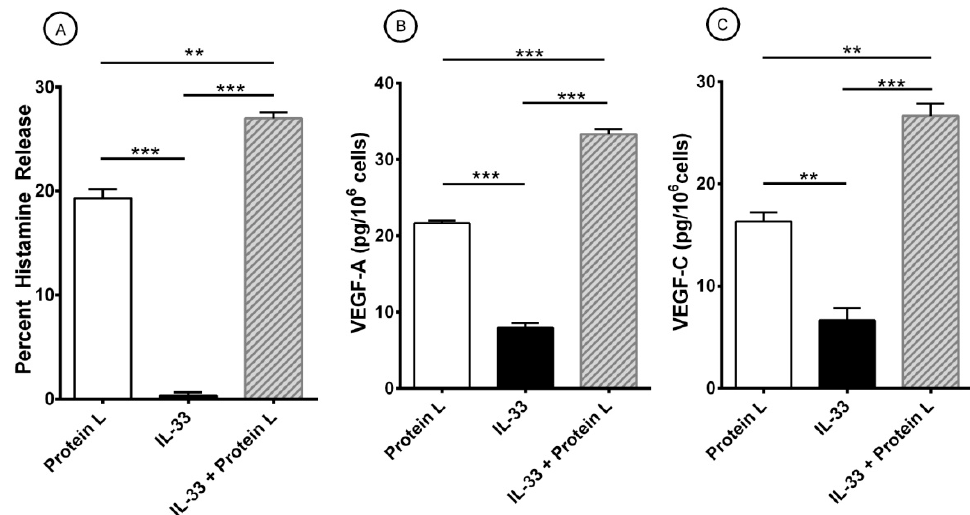
Figure 5. Effects of short-term priming by IL-33 and protein L-induced release of histamine ( A ), VEGF-A ( B ), and VEGF-C ( C ) from HLMCs. Mast cells were preincubated (30 min at 37 ◦ C) with IL-33 (30 ng/ml) before exposure to protein L (100 nM). After 45 min incubation at 37 ◦ C, HLMCs were harvested, centrifuged, and histamine release measured in the supernatants. For the evaluation of VEGFs, HLMCs were incubated for 12 h at 37 ◦ C. At the end of incubation, cells were harvested, centrifuged and VEGF-A and VEGF-C measured in the supernatants. Results show the mean ± SEM of triplicate determinations obtained in a typical experiment. ** p < 0.01; *** p < 0.001.